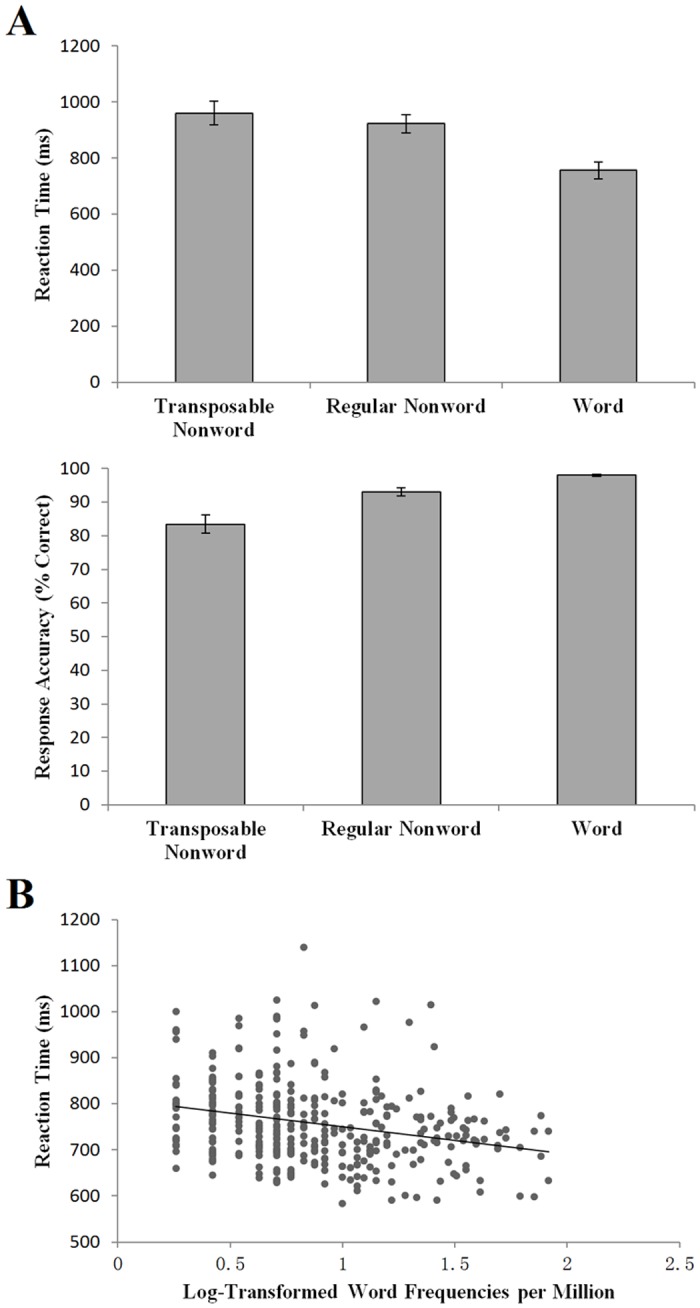
Behavioral results of the fMRI experiment.(A) the reaction times and accuracies of the word, regular nonword, and transposable nonword conditions (the error bars depict the unbiased standard errors of the data); (B) correlation between the log-transformed word frequencies and RTs across items of the word condition (r = -0.26, p < 0.001).